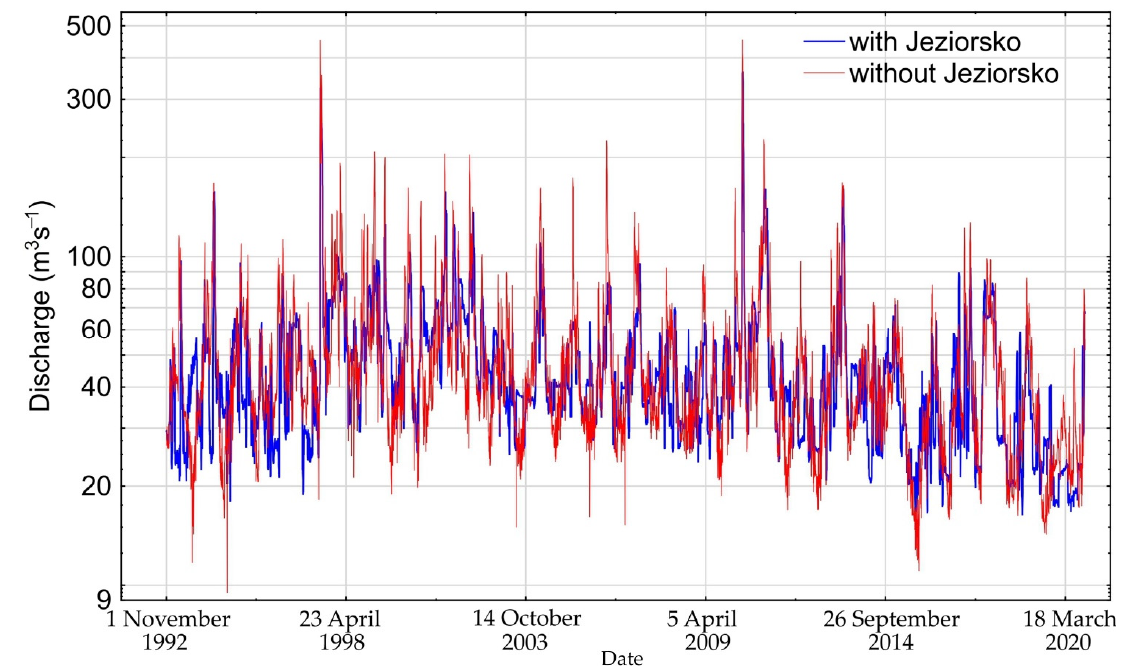
Figure 2. Course of daily flows in the Warta River in hydrological station Uniejów with and without the Jeziorsko dam reservoir.